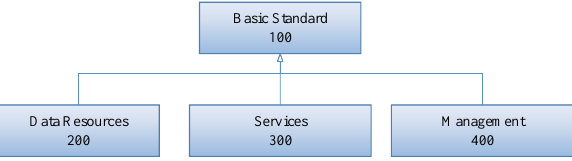
Figure 2 Architecture of geoinforamtion common services